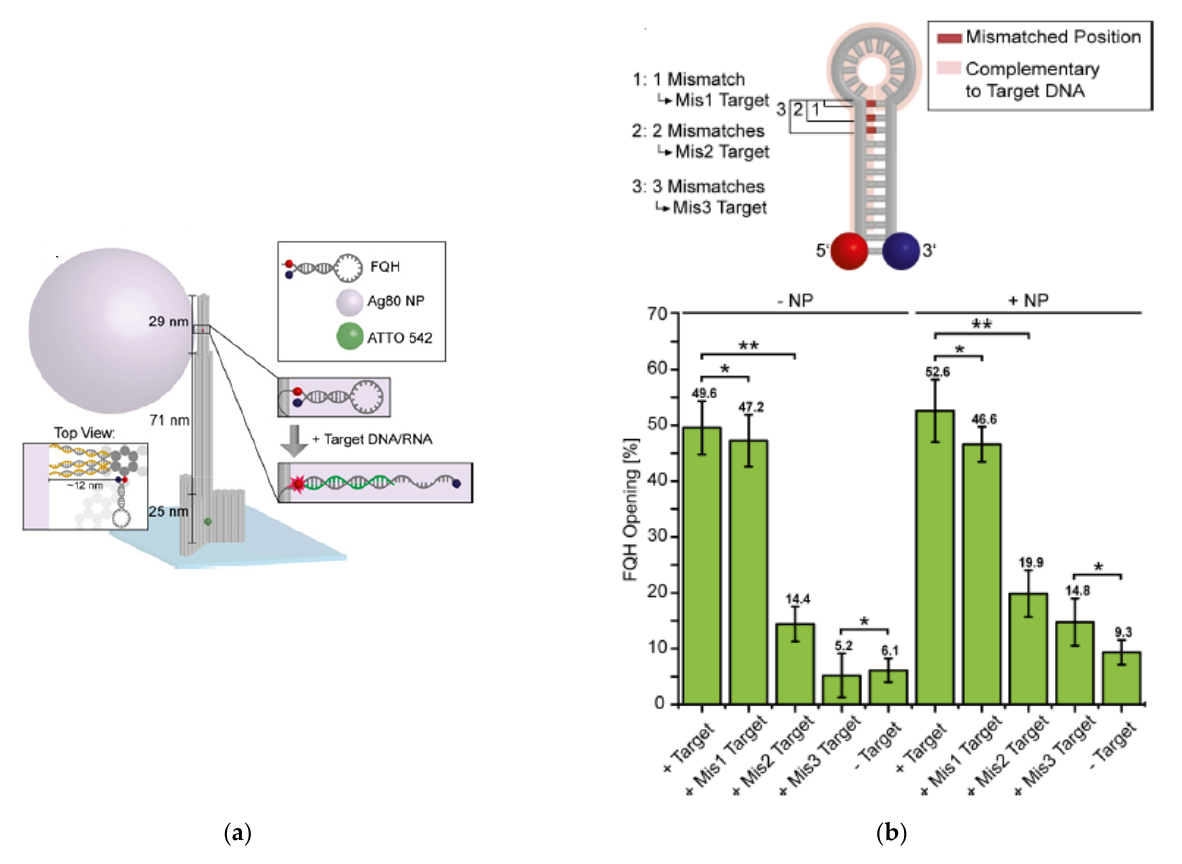
Figure 8. ( a ) DNA origami pillar with a total height of 125 nm is immobilized via biotin modifications on a BSA-biotin/neutravidin surface in a low concentration to ensure single molecule detection. An ATTO 542 dye is incorporated into its bottom part to localize the origami (green dot in sketch). On its upper part, a fluorescence-quenching hairpin (FQH) is bound to the pillar by extending its strand on the 5 ′ end. This allows incorporation of the FQH into the origami pillar during folding of the nanostructures (insets). Upon the addition of specific target DNA/RNA, the FQH is opened resulting in red fluorescence. To enhance the fluorescence arising from the FQH a silver nanoparticle (NP, 80 nm diameter) is attached to the origami as shown in the top view. The thiol-labeled oligonucleotides hybridize with the protruding strands of the DNA pillar; ( b ) Influence of single-nucleotide variations on hairpin opening, showing the schematic representation of mismatched positions of the target DNA complementary to the FQH sequence. Mis1 target has one mismatch located at position 1, Mis2 target two mismatches at position 2, and Mis3 target three mismatches at position 3. Fraction of opened FQHs after 18 h of incubation with 1 nM of respective target DNA and with and without the addition of NPs. Unpaired t test results:* p > 0.05 and ** p < 0.05.Adapted with permission from Ochmann et al. [42] Copyright © 2019 American Chemical Society.